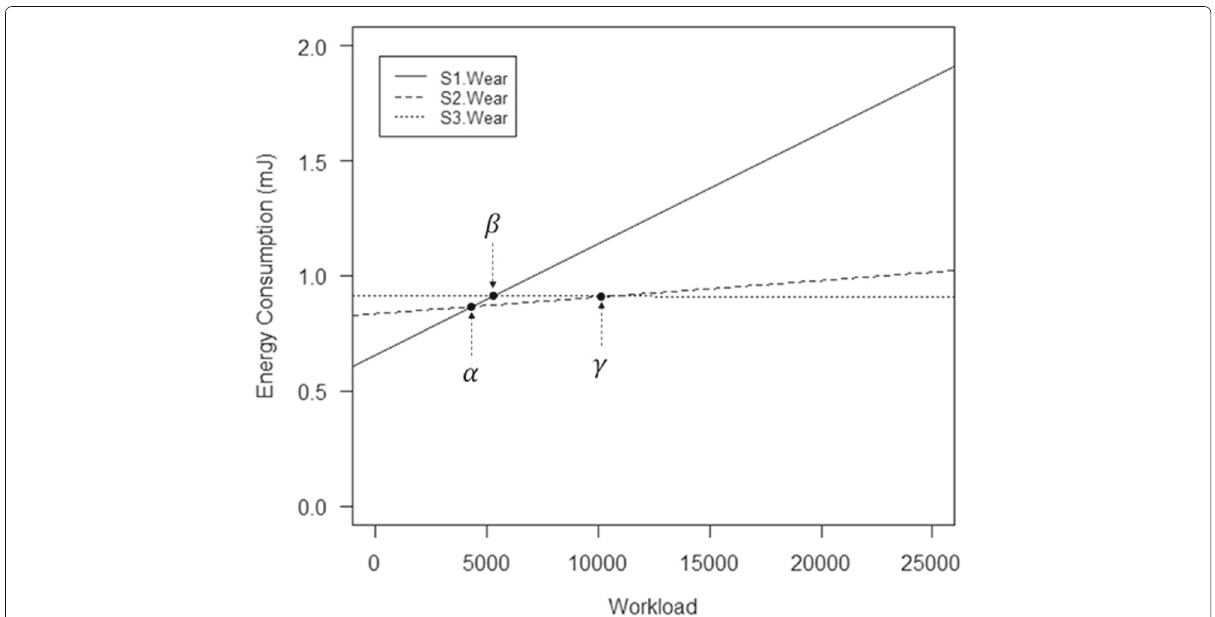
Fig. 7 Energy consumption of Smart Watch according to workload